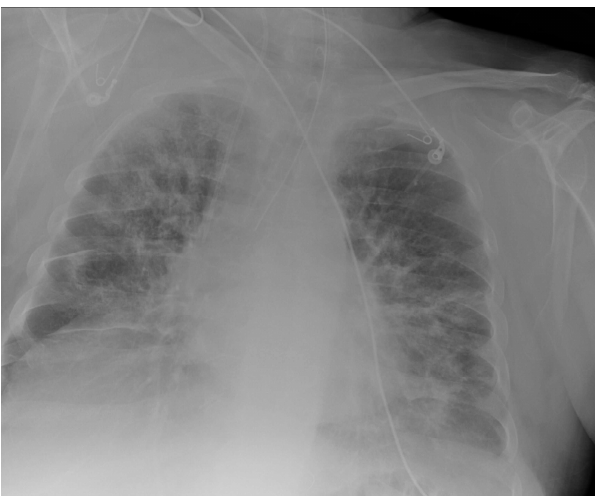
Figure 11. Image of mispositioned ETT whose tip has been pushed too deeply into the right